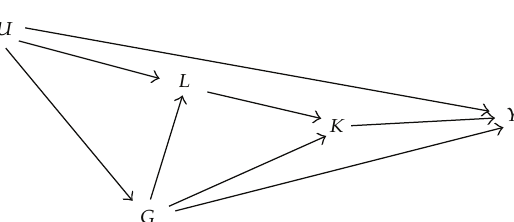
Figure 1: Causal diagram showing potential confounding mechanisms for the association between the genotype of a genetic marker G and the phenotype Y . The variable K denotes the intermediate phenotype, L the collection of known environmental and genetic risk factors, and U the unknown environmental and genetic risk factors such as population stratification and unknown genetic variants in linkage disequilibrium with G